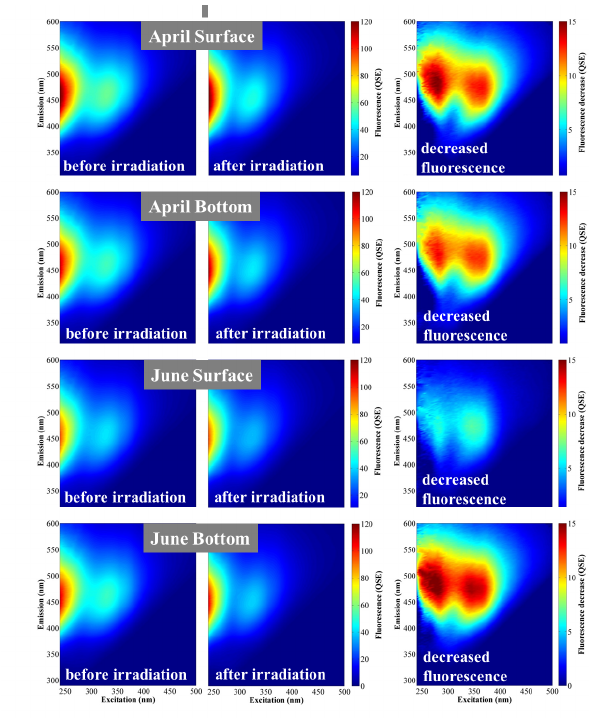
Fig. 4. Excitation emission matrix fluorescence of surface and deep SPE-DOM collected in April and June 2011 before and after ex- posure to simulated sunlight including a differential plot of the de- creased fluorescence after irradiation. Note: SPE-DOM was dried and then re-dissolved in pure water at pH 6.5. Fig. 5. Ultrahigh-resolution mass spectrum of SPE-DOM extracted